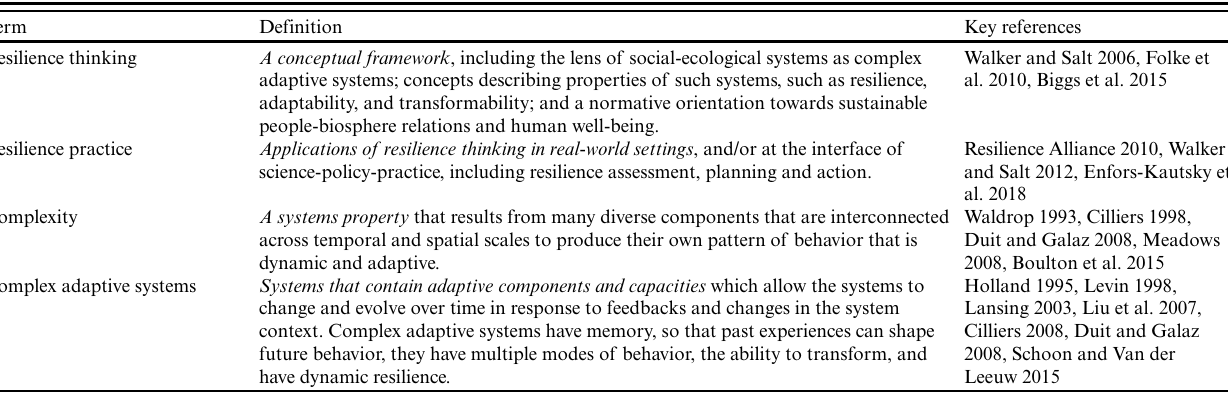
Table 1. Glossary of key terms. Resilience and complexity are terms that are defined and interpreted in many different ways. The following definitions and key references are used in this